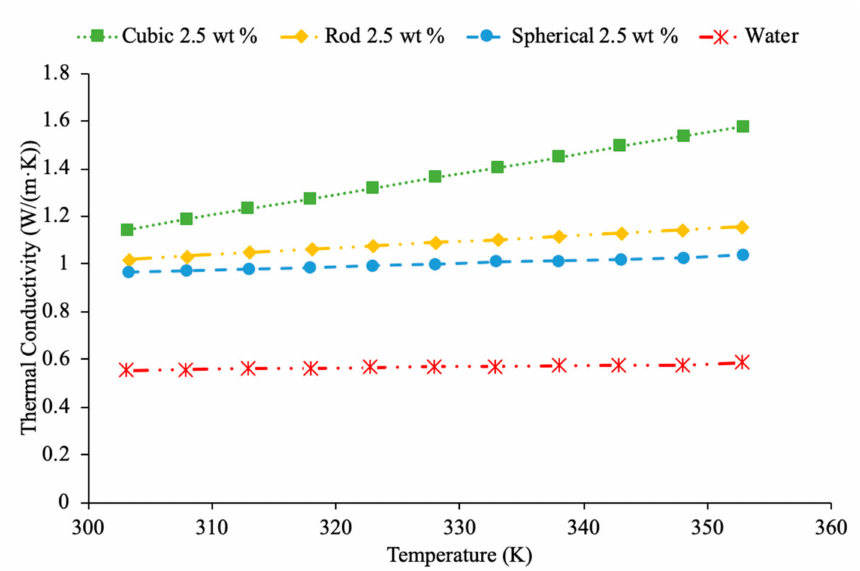
Figure 25. Thermal conductivity versus temperature for different shaped nanoparticles for TiO 2 water-based nanofluids using measurements